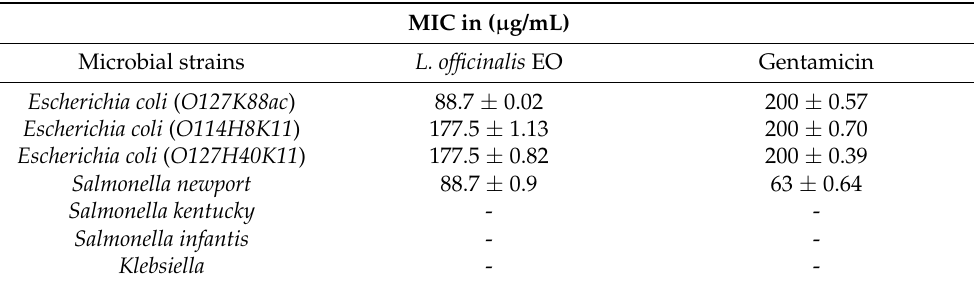
Table 3. Minimal inhibitory concentration (MIC) in ( µ g/mL) of L. officinalis EO and gentamicin against bacteria. Each MIC value is the mean of three replicates ±